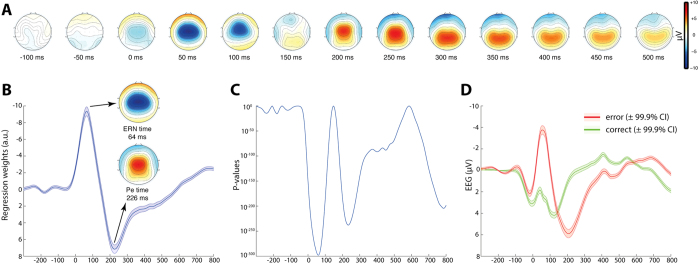
Error Effects on EEG Activity.Scalp topographies of response-locked regression weights show the classical ERN and Pe succession (A). Maxima for ERN and Pe were found at 64 ms and 226 ms, respectively, which both displayed central scalp topographies (B). Associated p-values for t-tests of within subject regression weights for a difference from zero are displayed with logarithmic scaling in (C). (D) Shows regular ERPs, which do not account for error-unspecific task effects (see Supplemental Material for details).